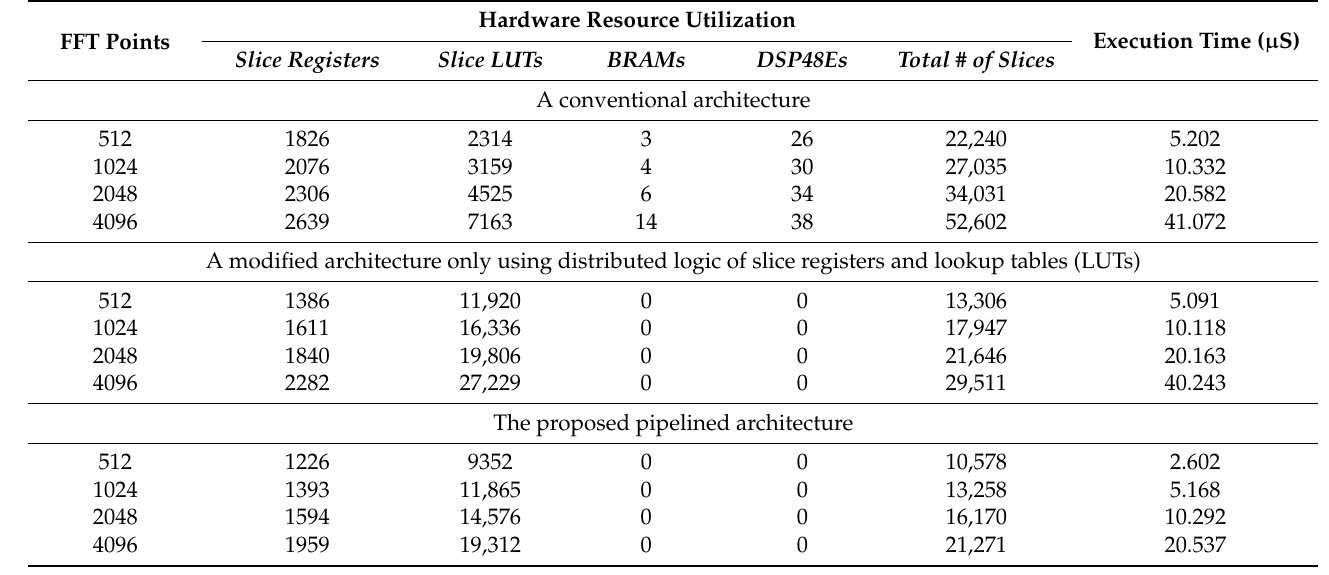
Table 6. Evaluation of the performance of the R2FB pipelined FFT processor with various